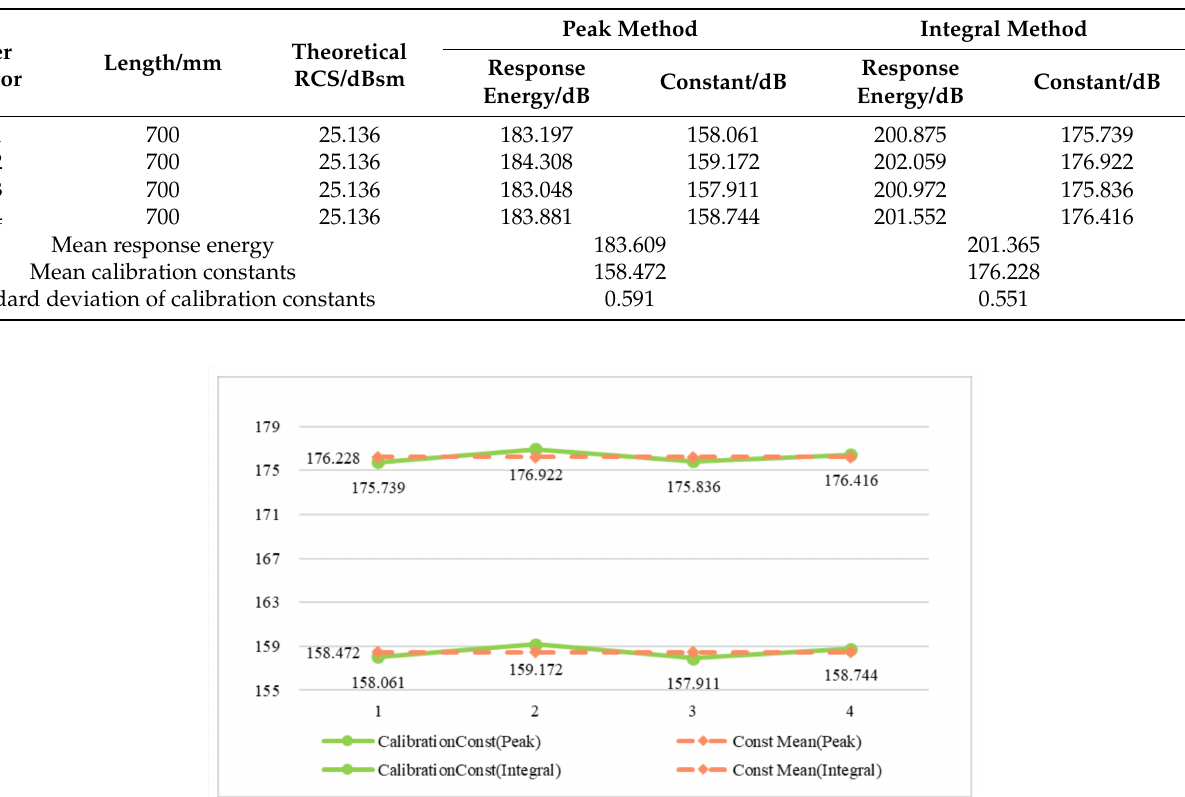
Table 6. Point target response energy and calibration constants obtained by the peak method and the integral method for the VV polarimetric image.